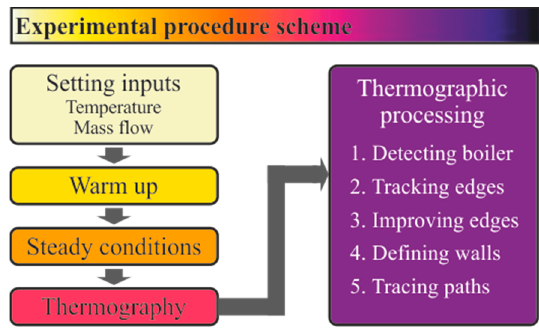
Figure 3. Scheme of the experimental procedure.